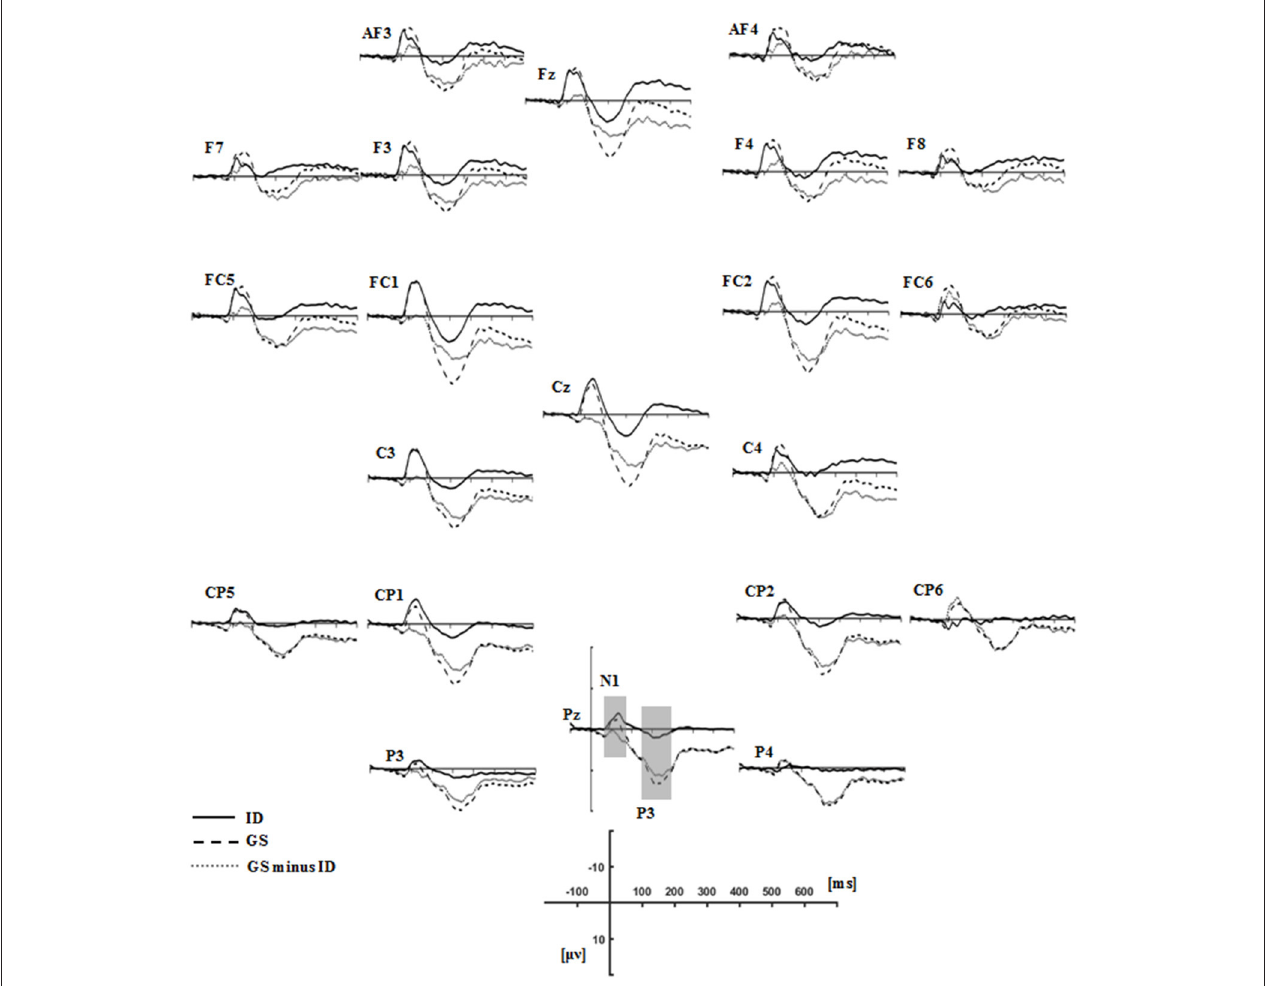
FIGURE 3 | Grand average ERPs time-locked auditory stop-signal stimuli in the successful-stop trials for the groups of insomnia disorders (ID, solid lines), good sleepers (GS, dash lines), and their difference waves (GS minus ID, gray dot lines). N1 (80–180ms) and P3 (230–400ms) components were labeled at the site where their peak latencies were